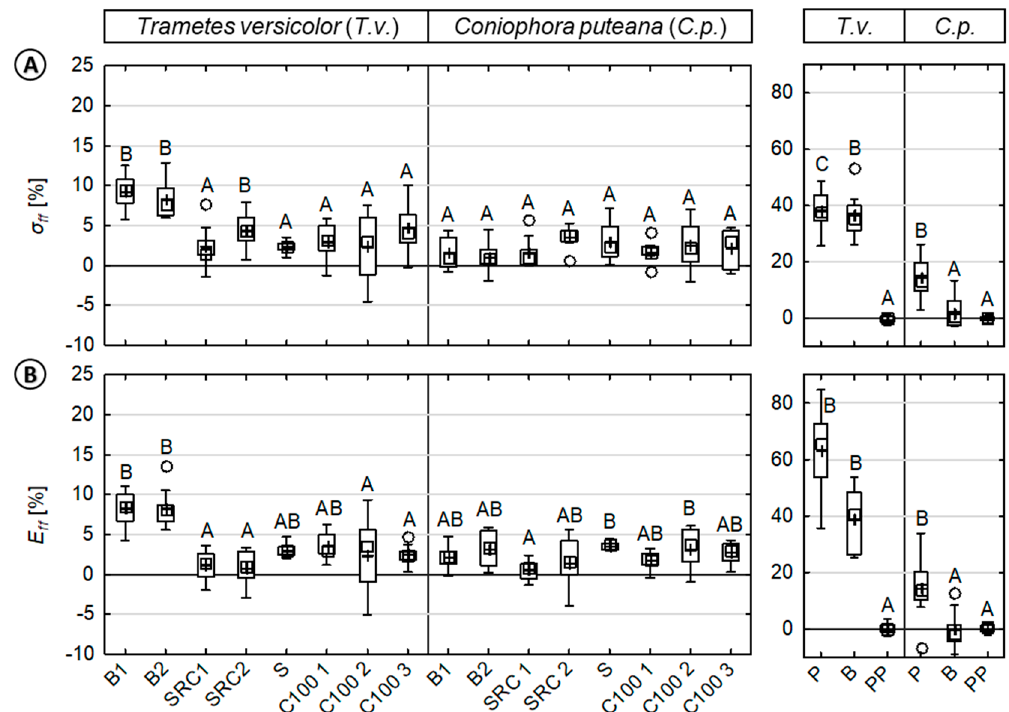
Figure 4. Loss in mechanical properties caused by fungi of injection molded wood–polypropylene composites and reference specimen against basidiomycetes. (Left): ( A ) MOR ( σ ff ) and ( B ) MOE ( E ff ) of composites / reference materials inoculated with Trametes versicolor ( T.v. ) or Coniophora puteana ( C.p. ) . (Right): For direct comparison, the MOR and MOE of the reference materials (beech wood, pine sapwood, and polypropylene) are shown. Results of the statistical analyses are displayed, whereas values assigned with the same letter are not significantly di ff erent from each other at a significance level of α = 0.05. (Kruskal-Wallis).